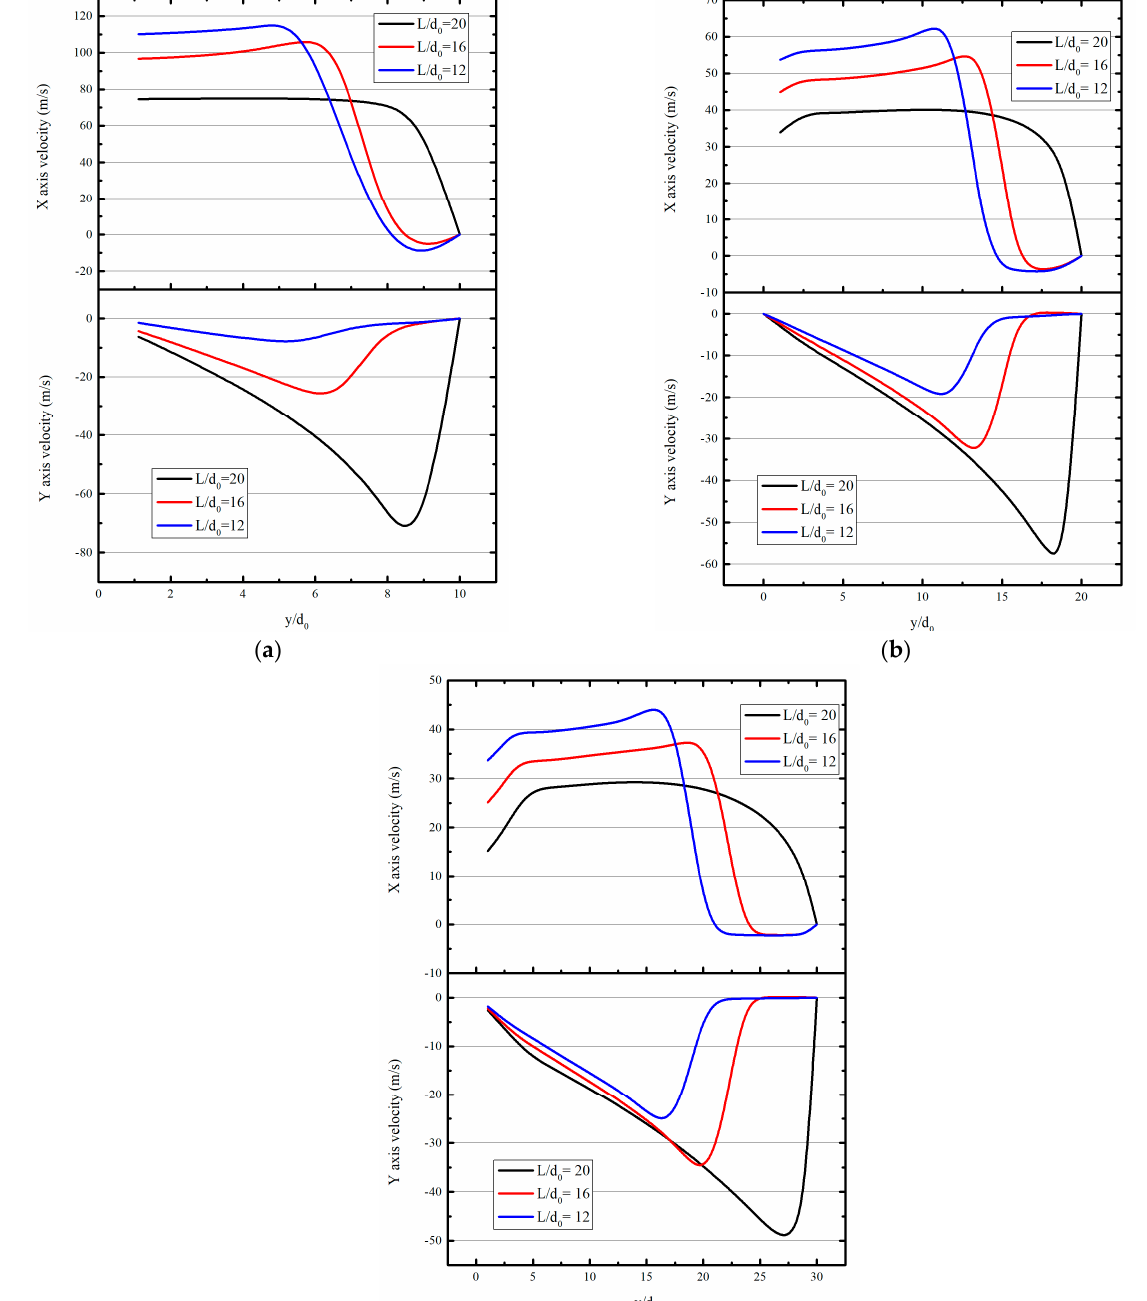
Figure 8. Crossflow x and y velocity by 𝐻 𝑑 (cid:2868) ⁄ at an air mass flow rate of 77g/s: ( a ) 𝐻 𝑑 (cid:2868) ⁄ = 10; ( b ) 𝐻 𝑑 (cid:2868) ⁄ = 20; and ( c ) 𝐻 𝑑 (cid:2868) ⁄ = 30.